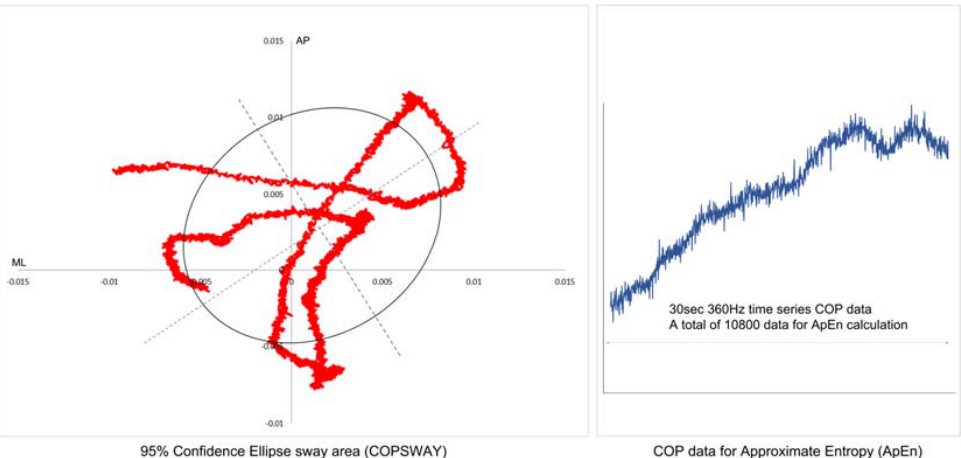
Figure 2. The 95% Confidence Ellipse sway (COPSWAY) and Approximate Entropy calculated by the center of pressure during the 30 s postural task.